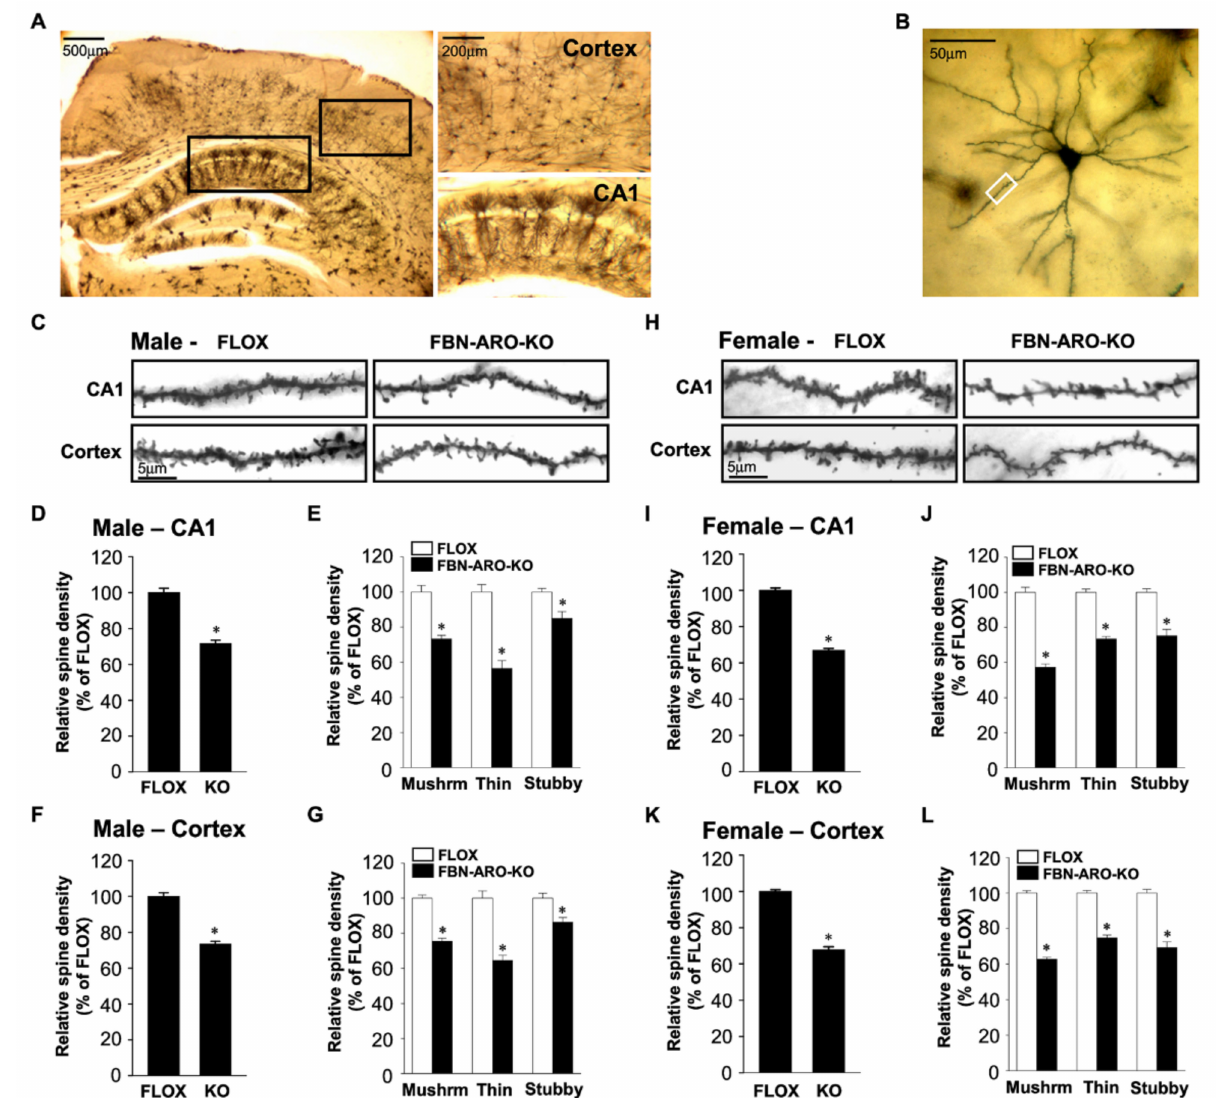
Figure 3. Dendritic spine density was decreased in both male and ovariectomized female FBN-ARO-KO mice. ( A ) Repre- sentative images of coronal sections subjected to Golgi staining from the cortex and hippocampal CA1 region. ( B ) Repre- sentative single neuron morphology with Golgi staining and the framed apical dendrite section for spine density analysis. ( C ) Representative images of selected dendritic segments from the hippocampal CA1 region and cortex of male FLOX and FBN-ARO-KO mice. ( D ) Quantitative analysis of mean spine density in the hippocampal CA1 region from FLOX and FBN-ARO-KO male mice. ( E ) Quantitative analysis for the changes of different spines, which were classified into mushroom, thin, and stubby based on their morphology. ( F , G ) Quantitative analysis of both (F ) mean spine density and ( G ) different spine morphologies in the cortex of FBN-ARO-KO mice. ( H ) Representative images of dendritic spines from hippocampal CA1 pyramidal and cortical neurons of ovx female FLOX and FBN-ARO-KO mice. ( I , J ) Quantitative analysis of ( I ) mean spine density and ( J ) the classified spines in the hippocampal CA1 region from ovx female FLOX and FBN-ARO-KO mice. ( K , L ) Group data of ( K ) mean spine density and ( L ) classified spines in cortex of ovx female FLOX and FBN-ARO-KO mice. Values are means ± SEM. N = 5. * p < 0.05 vs. FLOX group. Mushrm = Mushroom. Adapted from